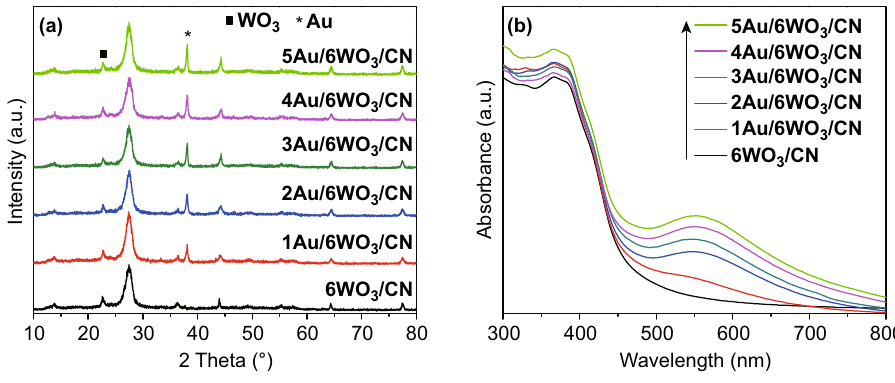
Fig. 1 a XRD patterns, and b UV–Vis absorption spectra of 6WO 3 /CN and y Au/6WO 3 /CN